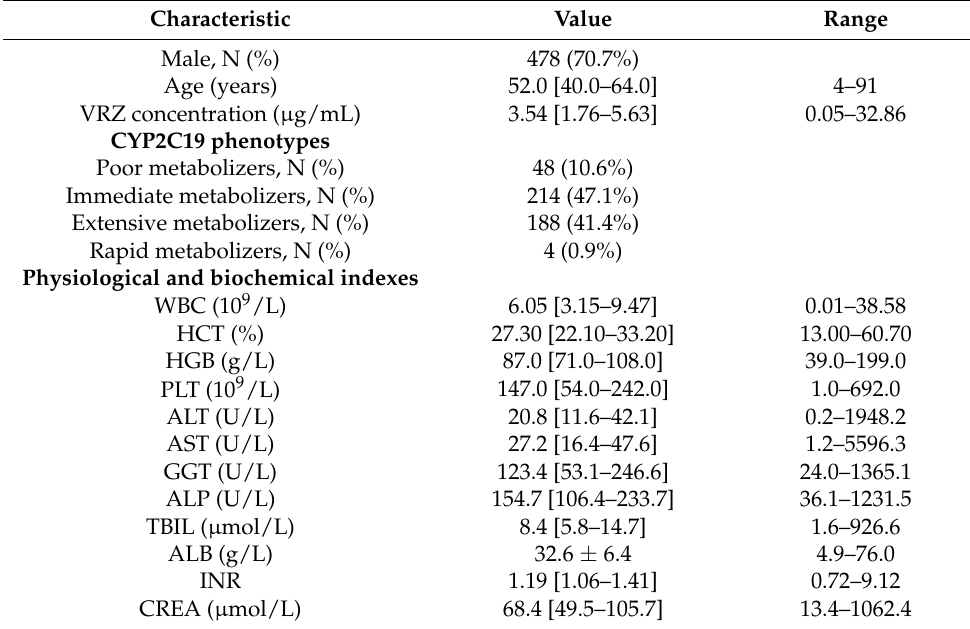
Table 1. Clinical data of patients whose administration regimen of voriconazole is 200 mg q12h.